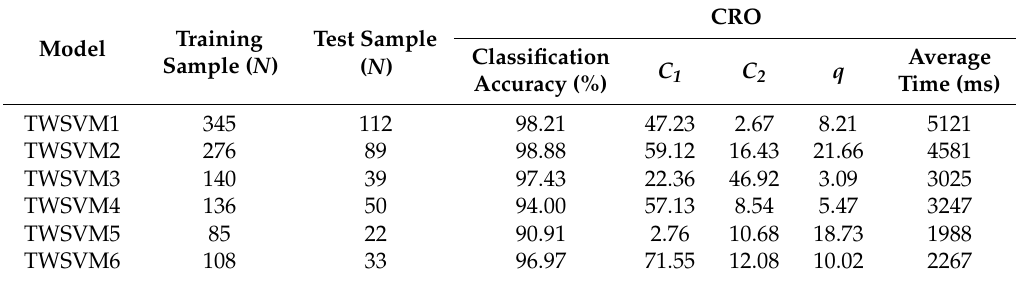
Table 4. Training results of CRO model with 5-fold